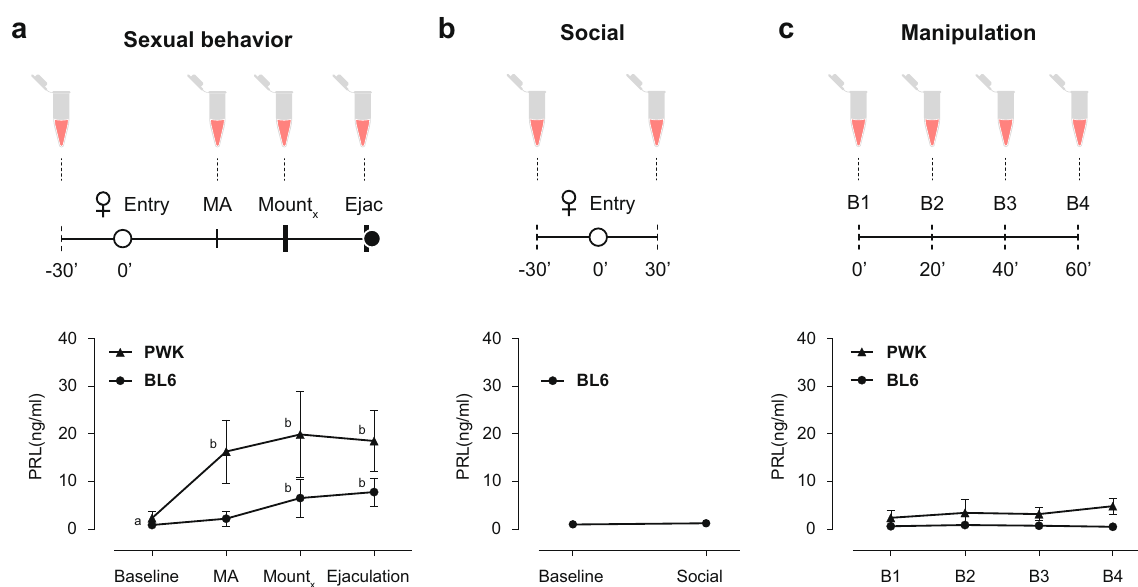
Fig. 1 Prolactin is released during sexual behavior in male mice. a Timeline for blood collection and [PRL] blood during sexual behavior (MA-mount attempt; BL6 Xmounts = 5; PWK Xmounts = 3). RM one-way Anova for BL6 ( n = 8) F 3,7 = 21.26, P < 0.0001 and PWK ( n = 9) F 3,8 = 17.18, P < 0.0001, followed by Tukey ’ s multiple comparison test ab P ≤ 0.01. b Timeline for blood collection and [PRL] blood during social behavior in BL6 males ( n = 15) P = 0.282, two- tailed paired t -test. c Timeline for blood collection and [PRL] blood during repeated sampling in resting condition. RM one-way Anova for BL6 ( n = 8) F 3,7 = 2.08, P = 0.18 and PWK ( n = 8) F 3,7 = 2.94, P = 0.11. Data represented as mean ±